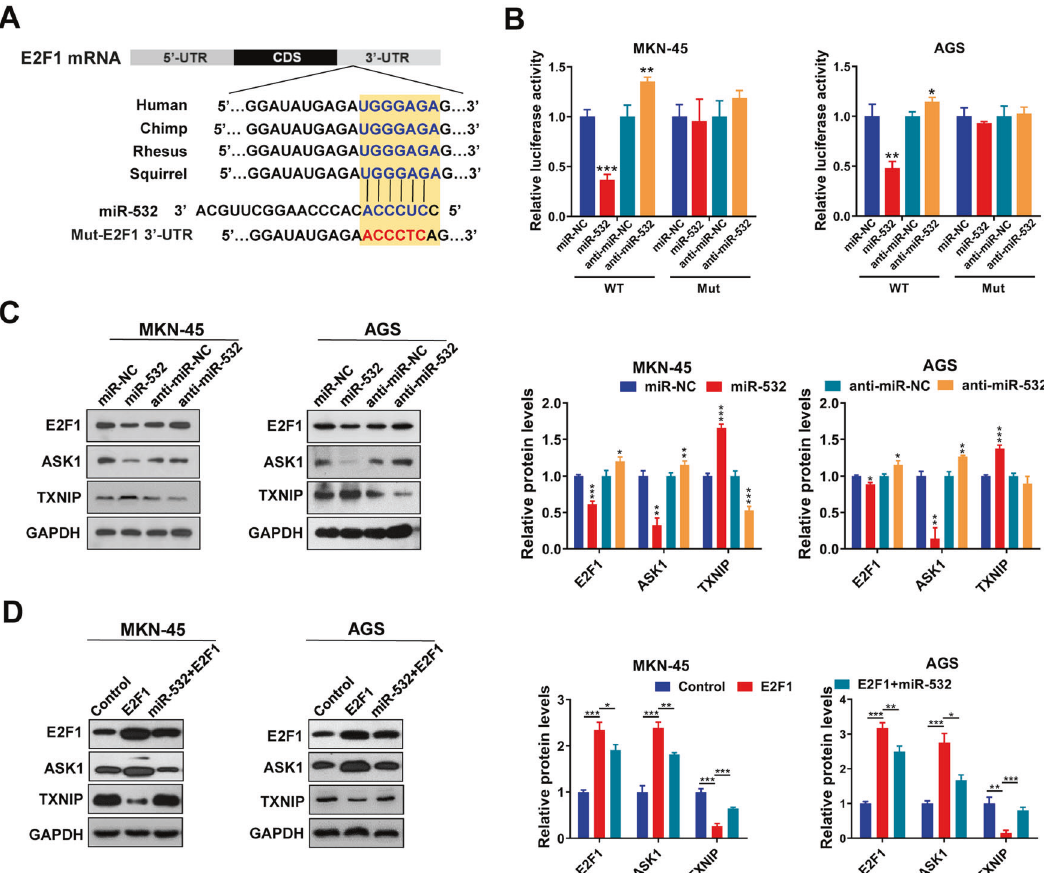
Fig. 4 miR-532 can directly inhibit E2F1 by binding to its 3 ’ -UTR. A Schematic diagrams of the predicted interaction between miR-532 and E2F1. B Relative luciferase activities in MKN-45 and AGS cells transfected with miR-532 mimics or inhibitors. C Western blotting analysis of E2F1 protein levels, as well as its downstream protein, ASK1 and TXNIP, in MKN-45 and AGS cells transfected with miR-532 mimics or inhibitors. D Western blotting analysis of E2F1, ASK1 and TXNIP protein levels in MKN-45 and AGS cells transfected with E2F1 overexpressing vector or miR-532 mimics plus E2F1 overexpressing vector. * P < 0.05; ** P < 0.01; *** P < (Fig. 6A). Hence, we explore whether E2F1, a sequence-speci fi c transcriptional factor, could bind to the E2F1-responsive elements and regulate miR-532 expression. Furthermore, we knocked down or overexpressed E2F1 in MKN-45 cells and checked the response of miR-532 by quantitative RT-PCR. Downregulation of E2F1 in MKN-45 cells resulted in a three-fold increase in miR-532 expression compared with cells transfected with a control siRNA, whereas E2F1 overexpression lead to a two-fold decrease in miR- 532 expression (Fig. 6B, C). Similar alteration in the levels of the CLCN5 mRNA was observed (Fig. 6D), suggesting that miR-532 alteration was likely due to the transcriptional changes. To check whether E2F1 directly binds speci fi c motifs in miR-532 (CLCN5) promoters, we performed chromatin immunoprecipitation (ChIP) assays in MKN-45 cells. The ChIP assay results con fi rmed that E2F1 proteins were recruited to binding sites 2 and 3 in the CLCN5 promoter (Fig. 6E, F). Next, we cloned the sequences of E2F1- binding sites 2 or 3 into an upstream region of a fi re fl y luciferase reporter gene and transfected the resulting plasmids into MKN-45 cells. Luciferase reporter assays revealed that E2F1 knockdown increased the transcription of fi re fl y luciferase in both plasmids with E2F1 binding site 2 or 3 sequences; however, when the binding sequences of sites 2 and 3 were mutated, fi re fl y luciferase activity was unaffected by E2F1 inhibition (Fig. 6G). Altogether, these results demonstrate that E2F1 negatively regulates the transcription of miR-532 via speci fi c E2F1-binding motifs in the promoter region.